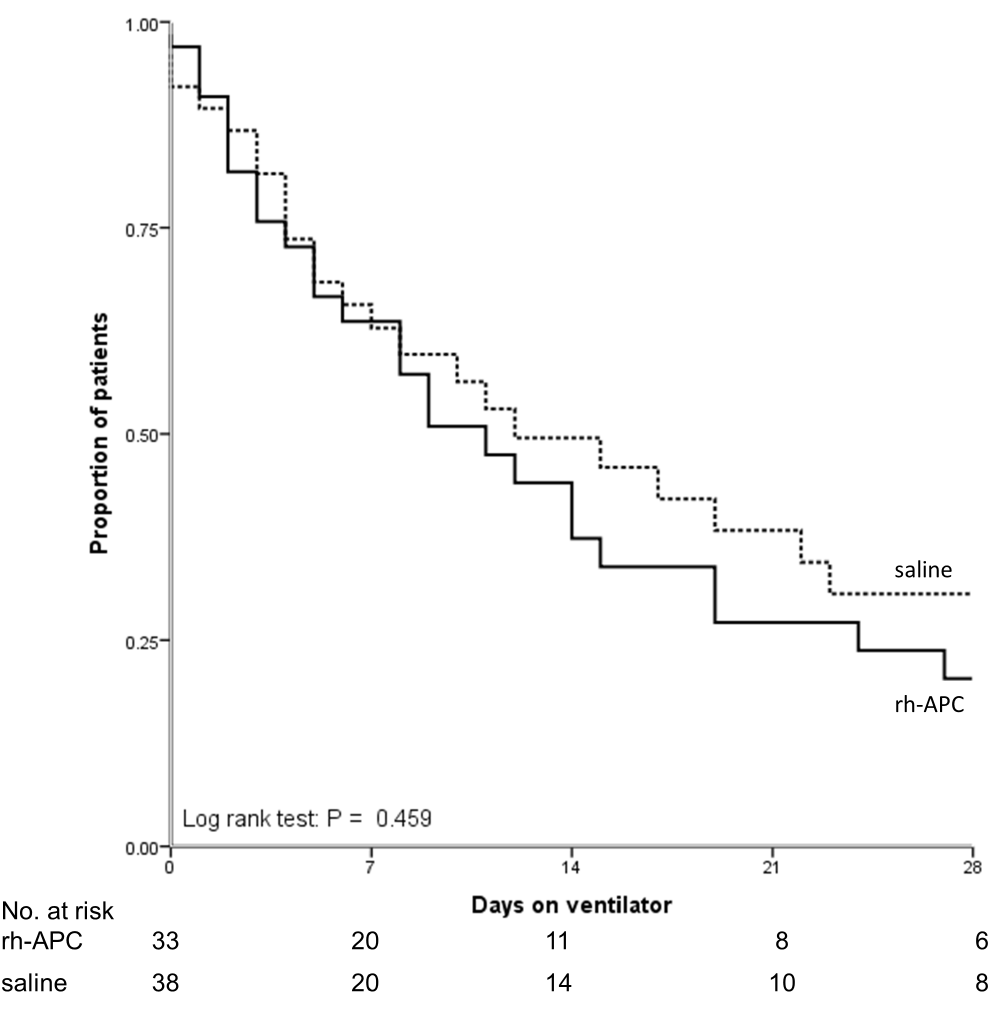
Figure 2. Probability of being alive and off the ventilator until day 28 in study groups.